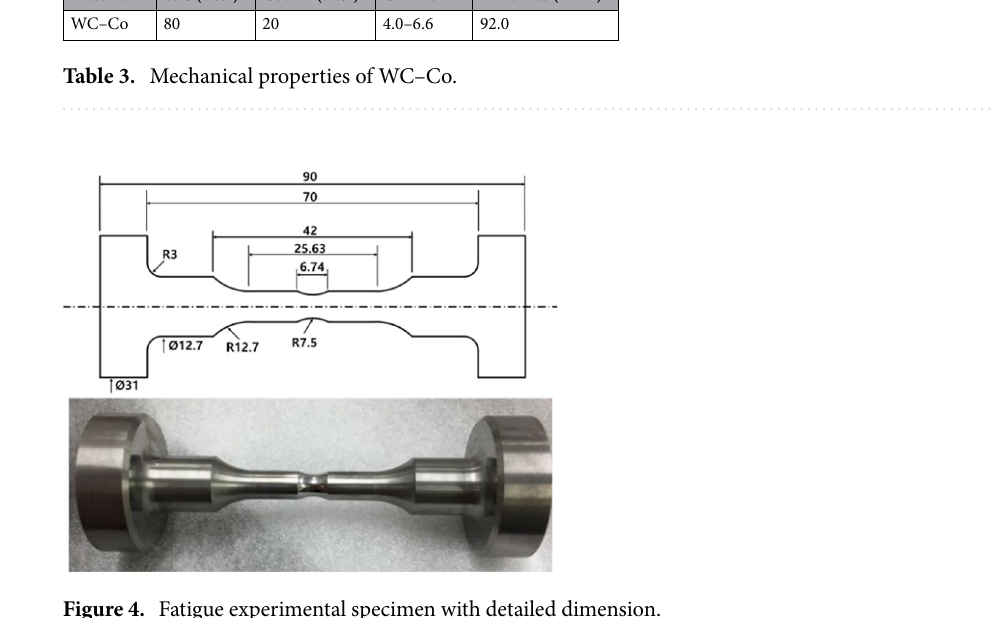
Figure 4. Fatigue experimental specimen with detailed dimension.